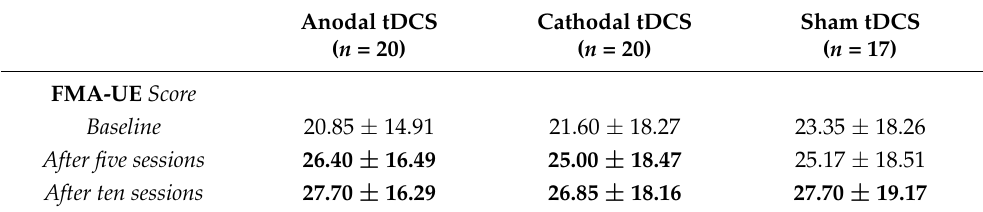
Numbers in bold indicate significant increase from baseline ( p ≤ 0.05). Paired samples test. Abbre-